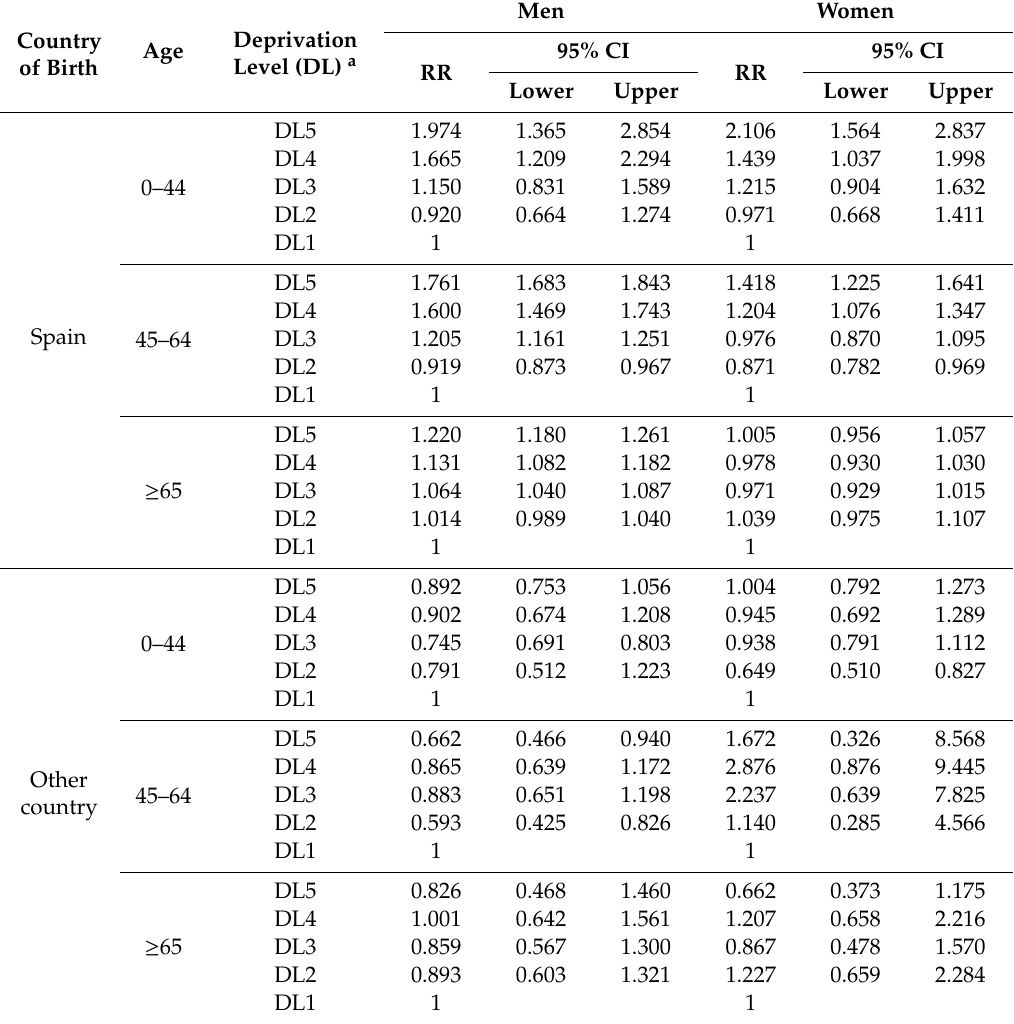
Table 4. Relative risks of death from all causes according to level of deprivation and 95% confidence intervals (95% CI), specific for age, sex and country of birth.